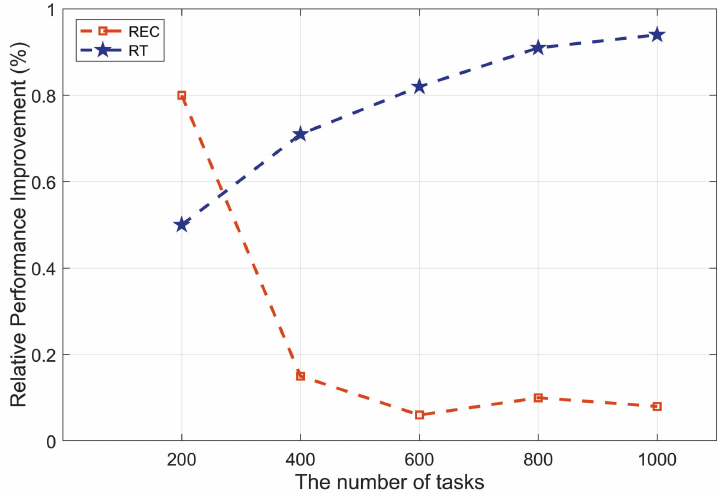
Figure 7. Task extensibility